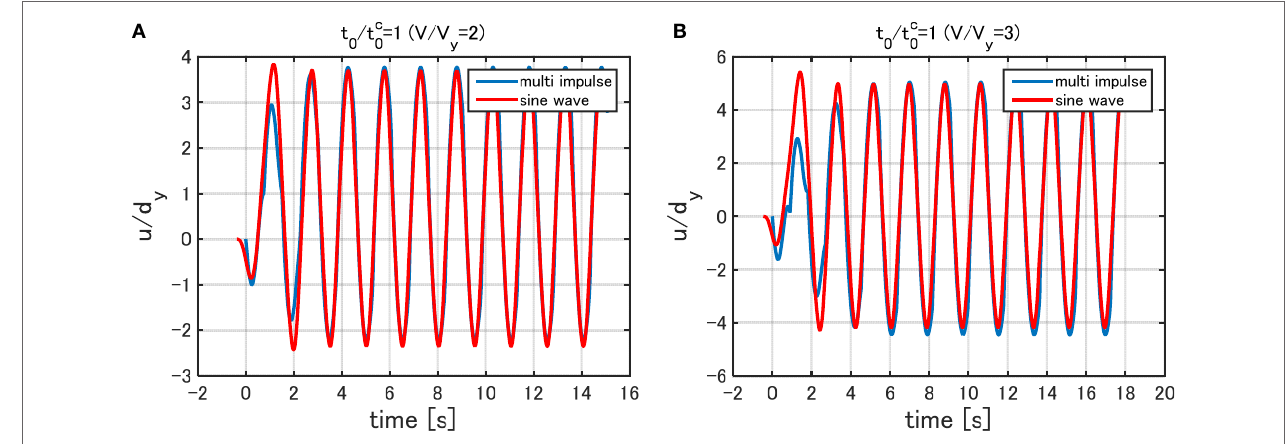
FigUre 13 | comparison of responses to multiple impulse and sinusoidal wave (phase lag has been adjusted): (a) V / V y = 2 and (B) V / V y = 3